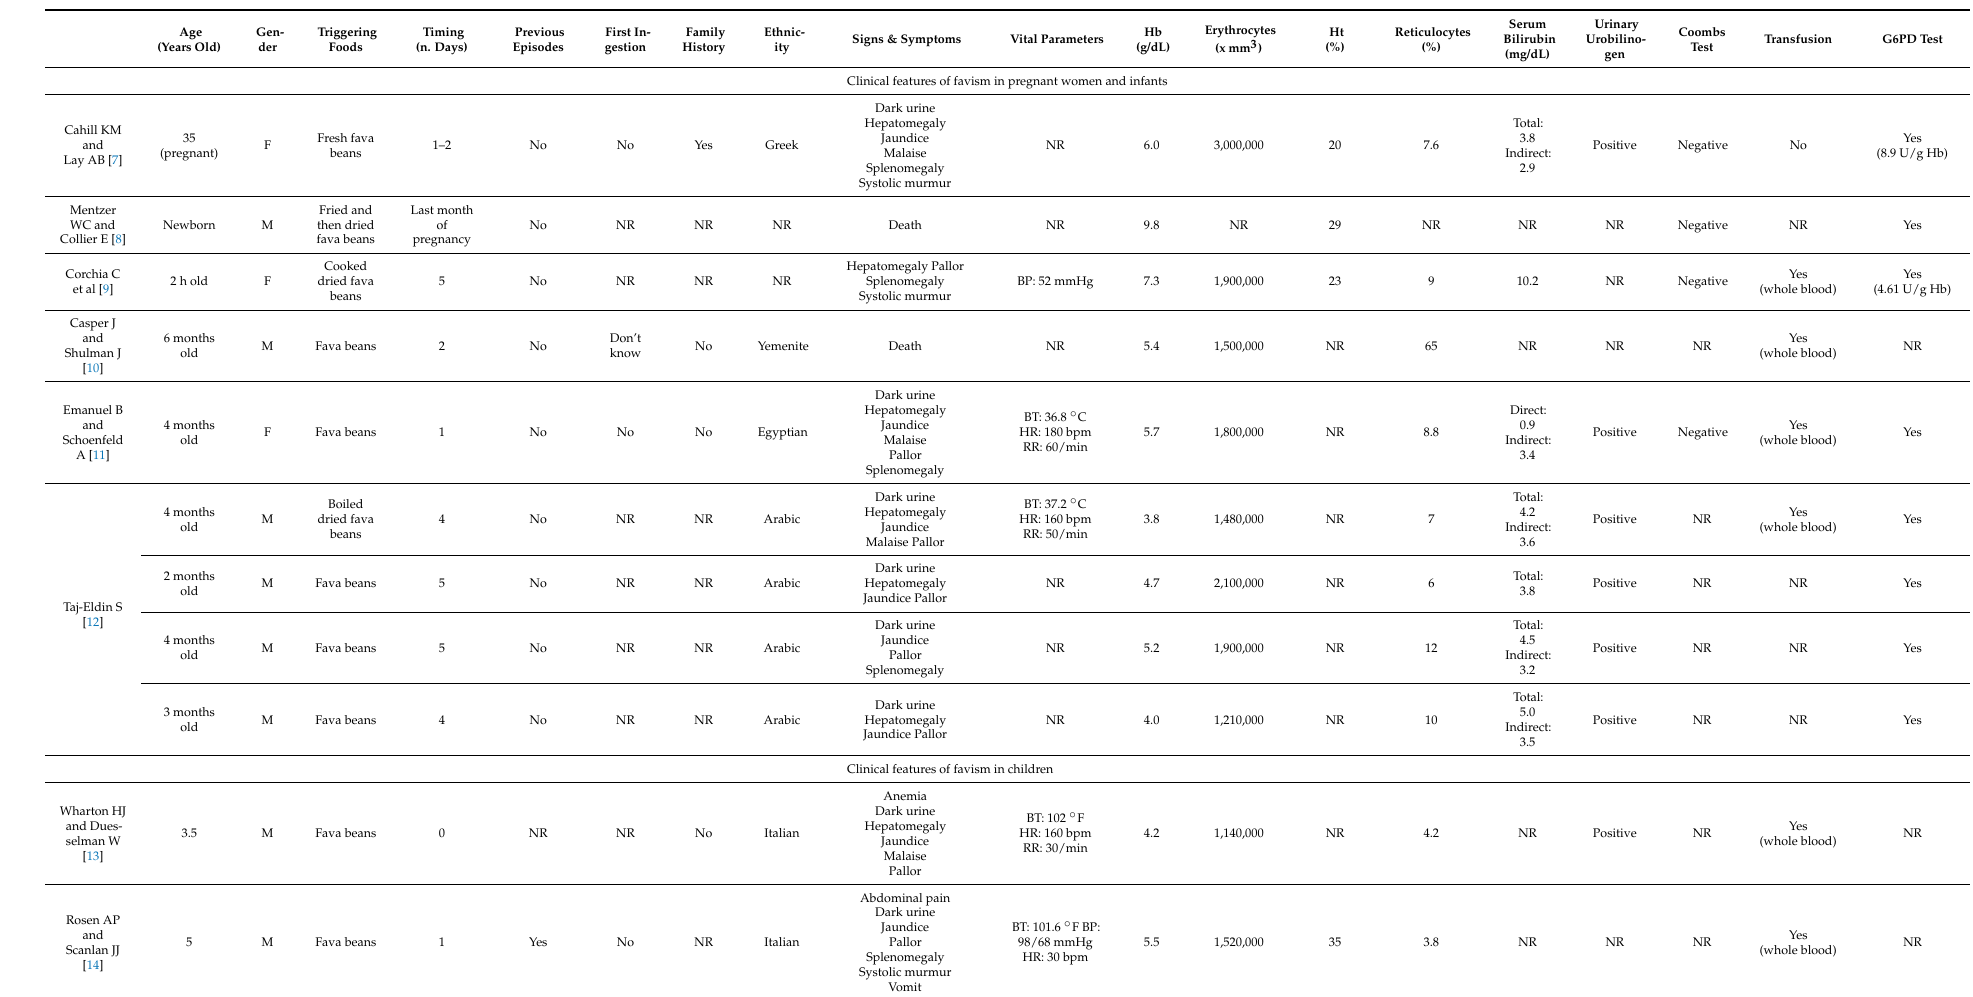
Table 2. Clinical features of favism in different age groups.